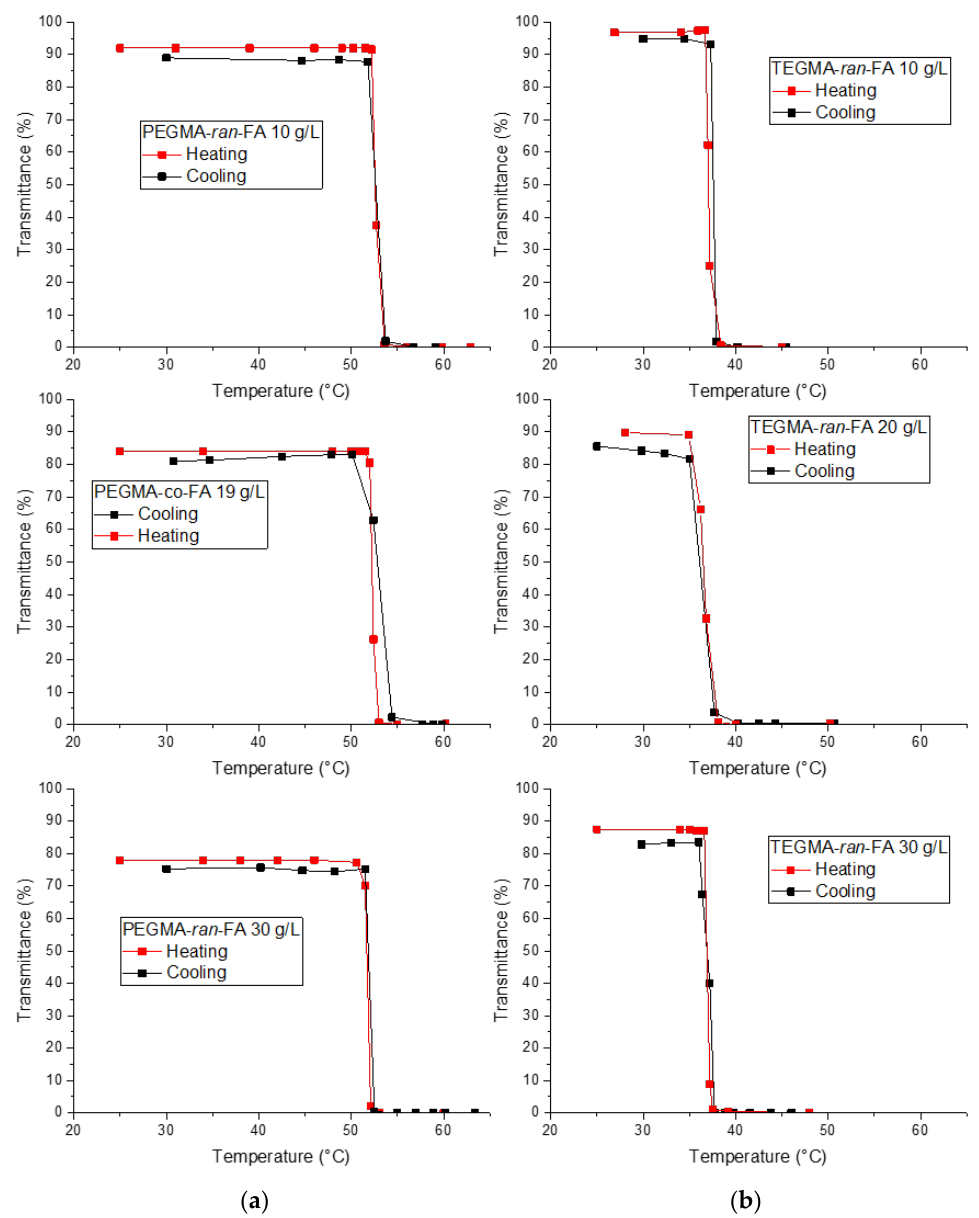
Figure 4. Turbidimetry measurements (λ = 700 nm) in water of PEGMA- ran -FA ( a ) and TEGMA- ran -FA ( b ) at varying concentrations.